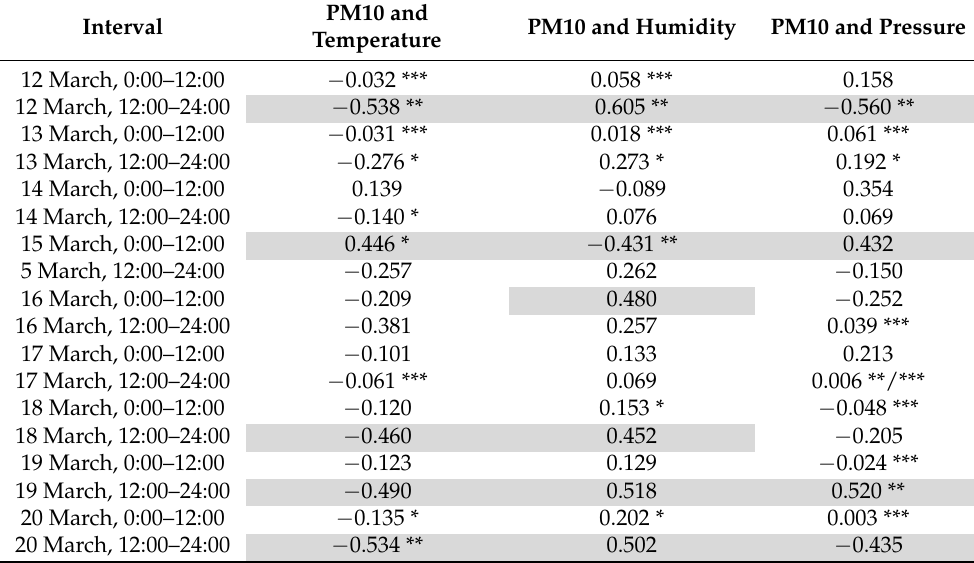
Table 11. Correlation between mass concentration of PM10 and temperature, humidity, pressure: balcony